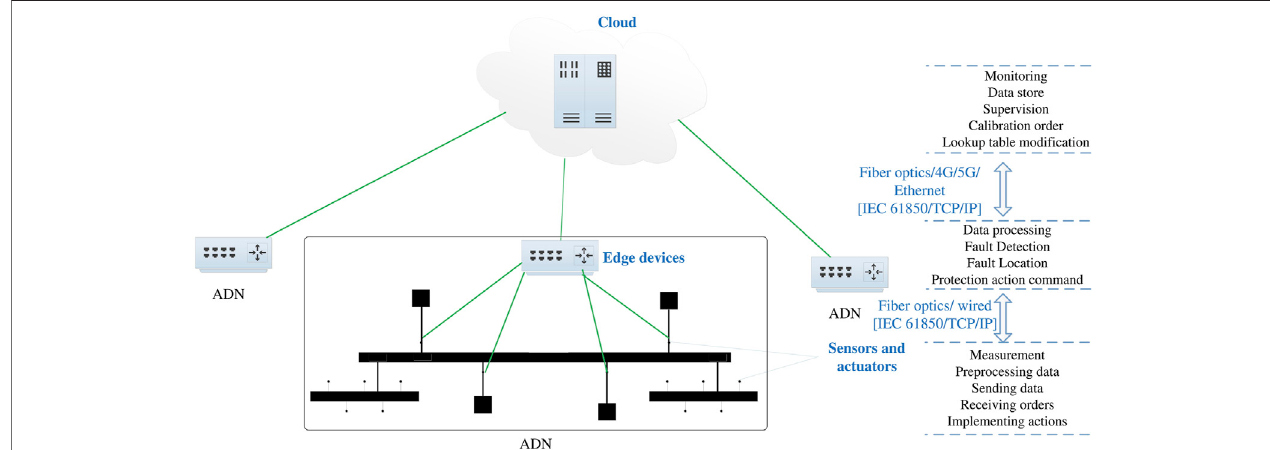
FIGURE 1 | Structure of cloud-based grid infrastructure with edge computing protection